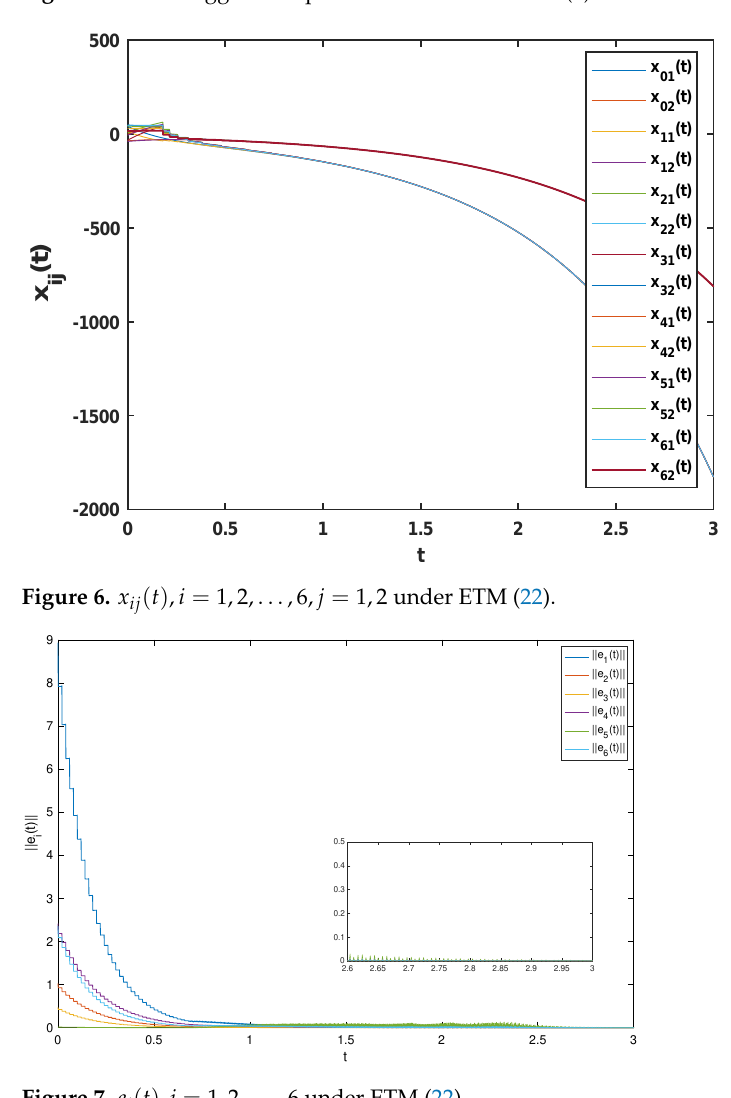
Figure 5. Event-triggered impulsive series under ETM (7).